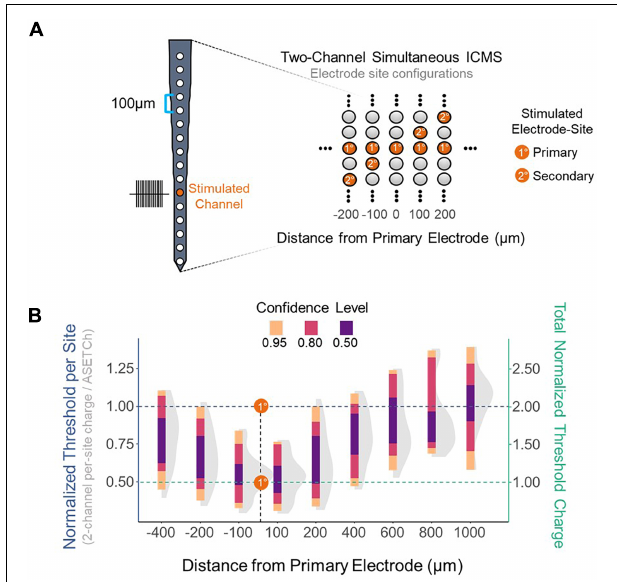
FIGURE 2 | Reduction in per-site threshold charge using simultaneous stimulation. (A) Layout of electrode shank and 2-site simultaneous stimulation paradigm. Primary electrode located 1,150 µ m from the cortical surface; secondary electrode spaced apart from primary in 100 µ m increments. (B) Detection thresholds for 2-site synchronous stimulation across different distances from the primary electrode normalized to average single-site threshold. Left Y axis – threshold charge per site divided by average primary electrode threshold charge. Right Y axis – sum of individual electrode threshold charges divided by average primary electrode threshold charge. Dashed lines represent the average single-channel threshold charge when stimulating with the primary electrode-site – normalized to